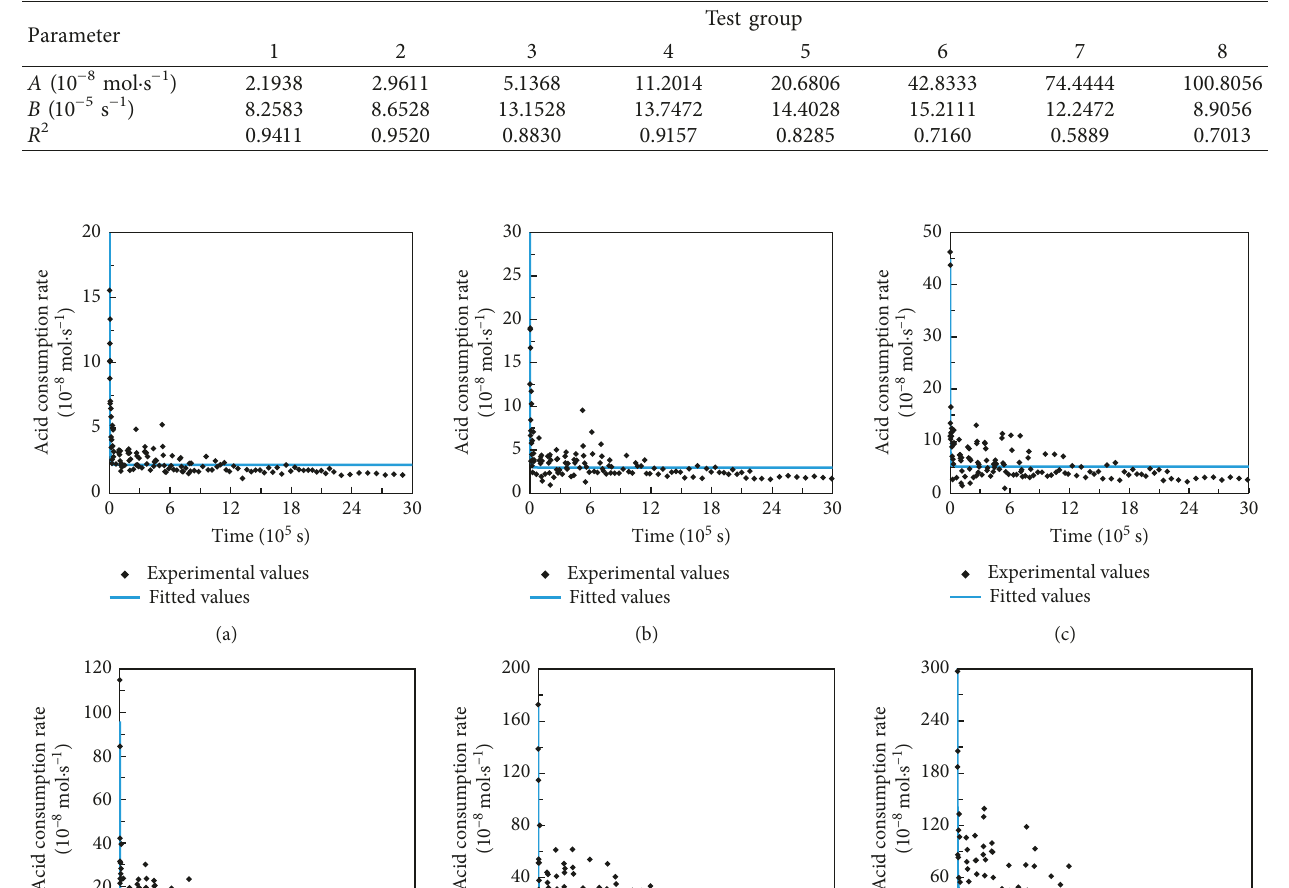
Table 5: Fitting parameters.